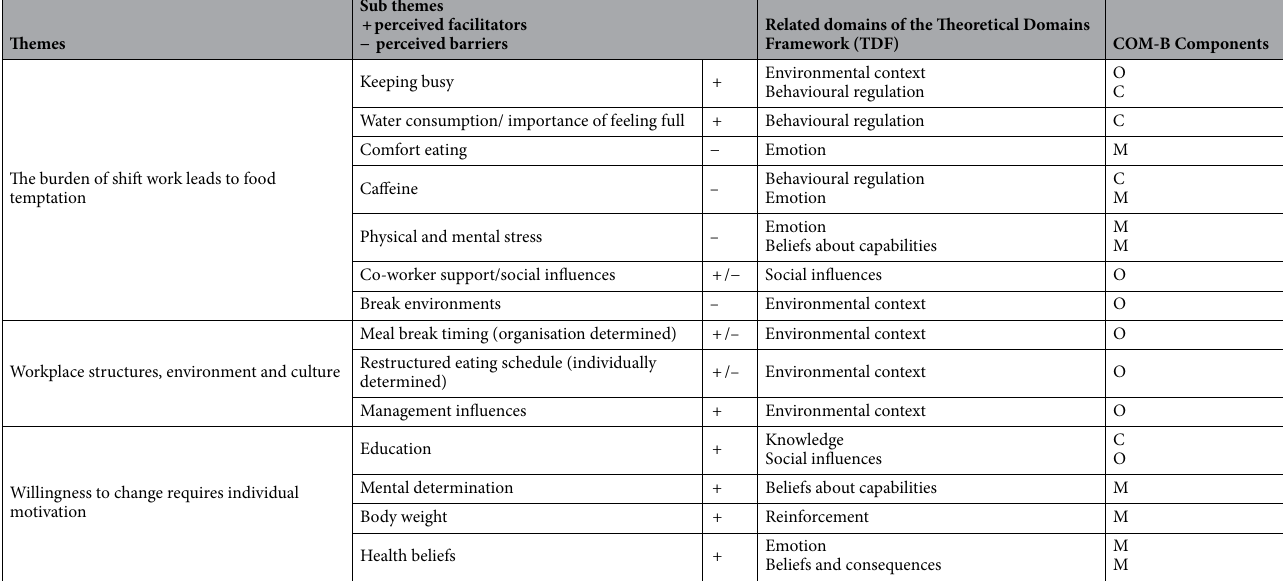
Table 3. Thematic representation of shift workers’ experiences and perceived feasibility of a meal timing intervention during night shift. Themes and subthemes are linked to the Theoretical Domains Framework (TDF) 22 and the behaviour change model constructs: Capability, Opportunity and Motivation (COM- B) 24 . + indicates the subtheme was reported as an enabler to following the intervention;—indicates